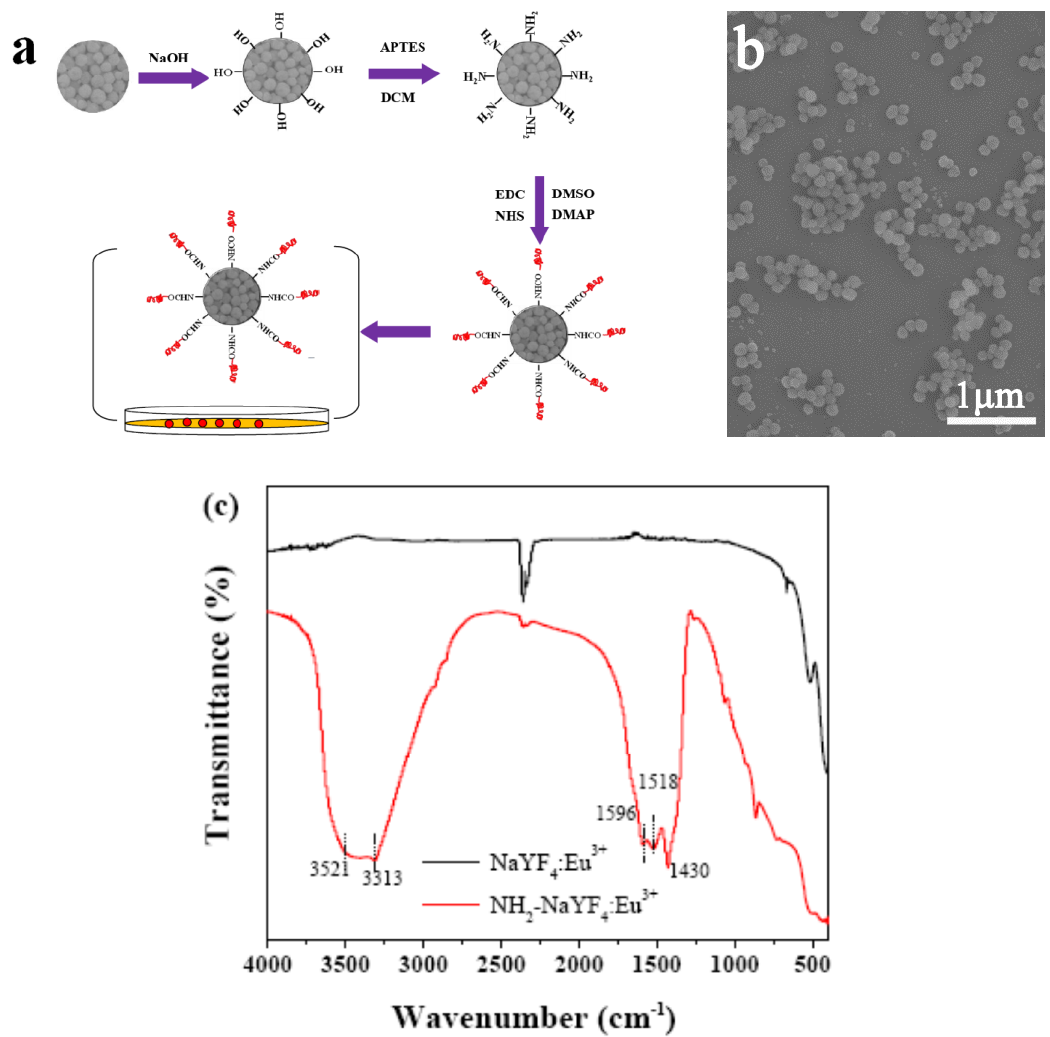
Figure 5. ( a ) Schematic diagram for the surface modification particles, ( b ) FE-SEM micrographs showing the morphology of NH 2 -NaYF 4 :Eu 3+ , and ( c ) the FT-IR spectra of NaYF 4 :Eu 3+ and NH 2 - NaYF 4 :Eu 3+ .